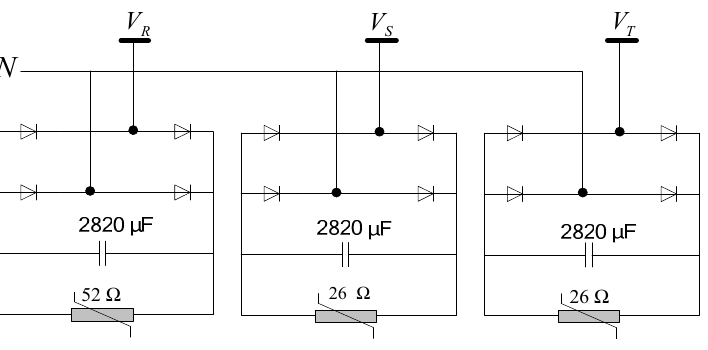
Figure 36. Three-phase, unbalanced, non-linear load.